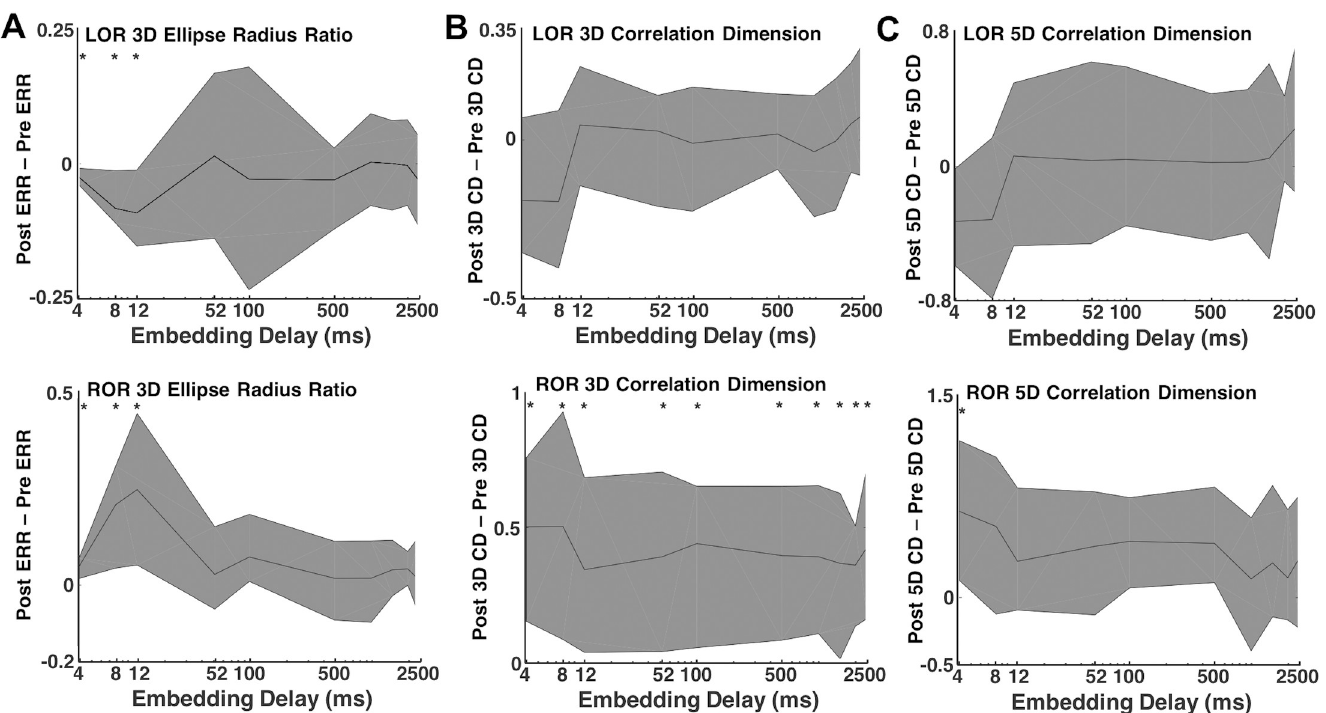
Fig 8. Attractor measures at increasing embedding delays for loss and recovery of response. Three-dimensional attractors were characterized using the ellipse radius ratio (ERR, A) and correlation dimension (CD) in both 3 (B) and 5 (C) dimensions. We calculated the differences in these three measures in 20 second EEG clips before and after LOR (top plots) and before and after ROR (bottom plots) at all embedding delays. The difference between the two clips before to after the events is shown here. Solid lines indicate the median differences for all patients at each delay and the shaded error represents the 25th and 75th quartiles. The � indicates a significant difference between pre- and post- clips in the EEG measures at that embedding delay at p < 0.05 corrected.